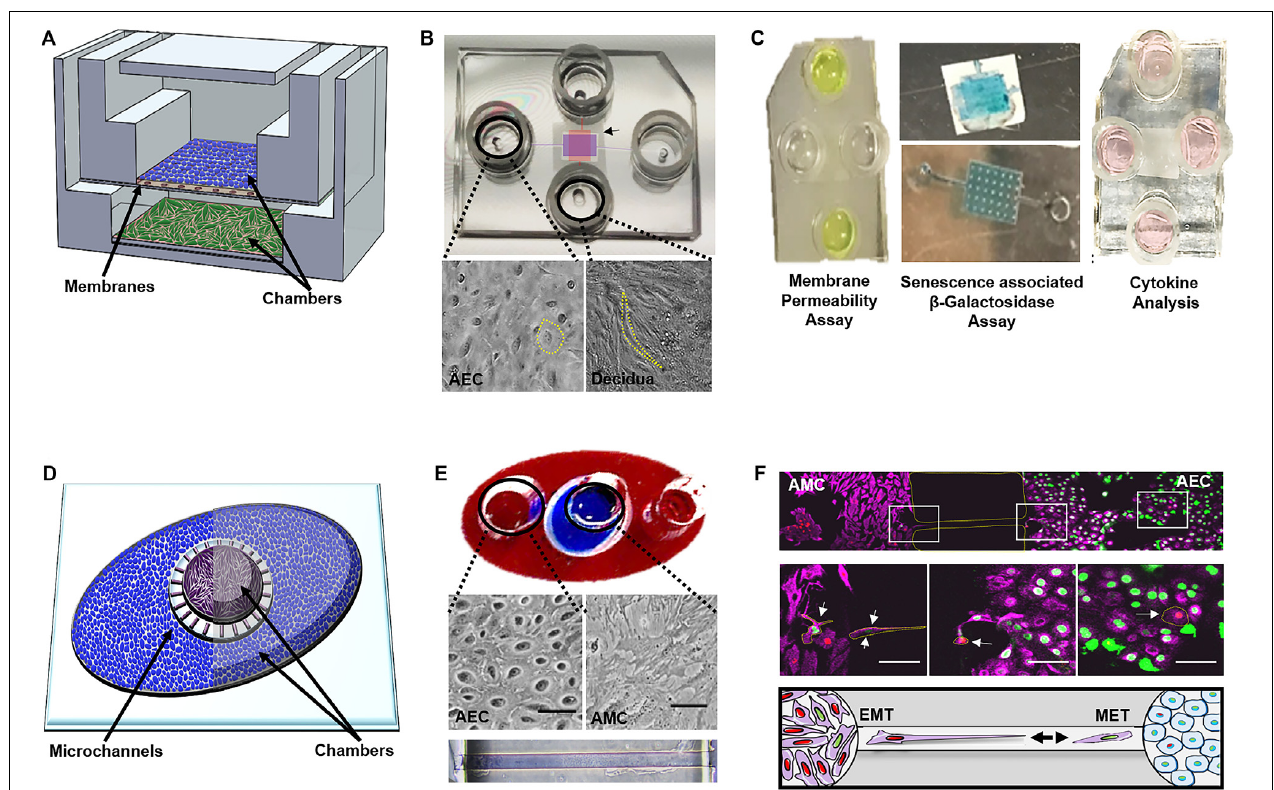
FIGURE 5 | Currently developed OOCs mimicking components of the fetal membranes and feto-maternal interface. (A) Device layout—schematic of the two-chamber fetal membrane-organ-on-chip (FM-OOC) developed to study fetal and maternal cell interactions at the fetal membrane interface adapted from Richardson et al. (2019a). The FM-OO-C is comprised of two stacked PDMS cell culture chambers that are coated with Matrigel (pink). Primary AECs (blue) are placed in the top chamber and grown on top of a polycarbonate semipermeable synthetic membrane, while primary decidual cells (green) are placed in the lower chamber and grown on the glass substrate. (B) Images of the fabricated FM-OO-C chips and cells being cultured within each compartment. Bright-field microscopy images of primary human AECs in the top chamber (purple) and primary decidual cells in the bottom chamber (red) are shown. The yellow outline visualizes